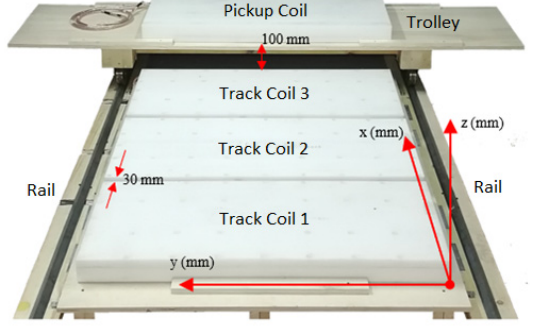
Figure 11. Layout of the experimental track.